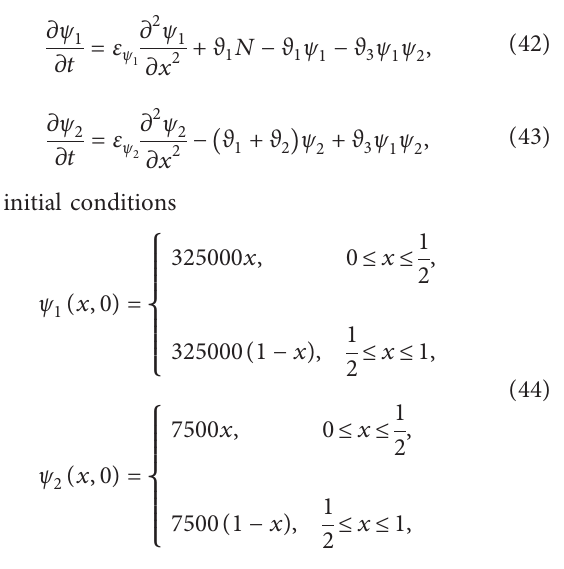
. (c) Plot graph of ψ 2